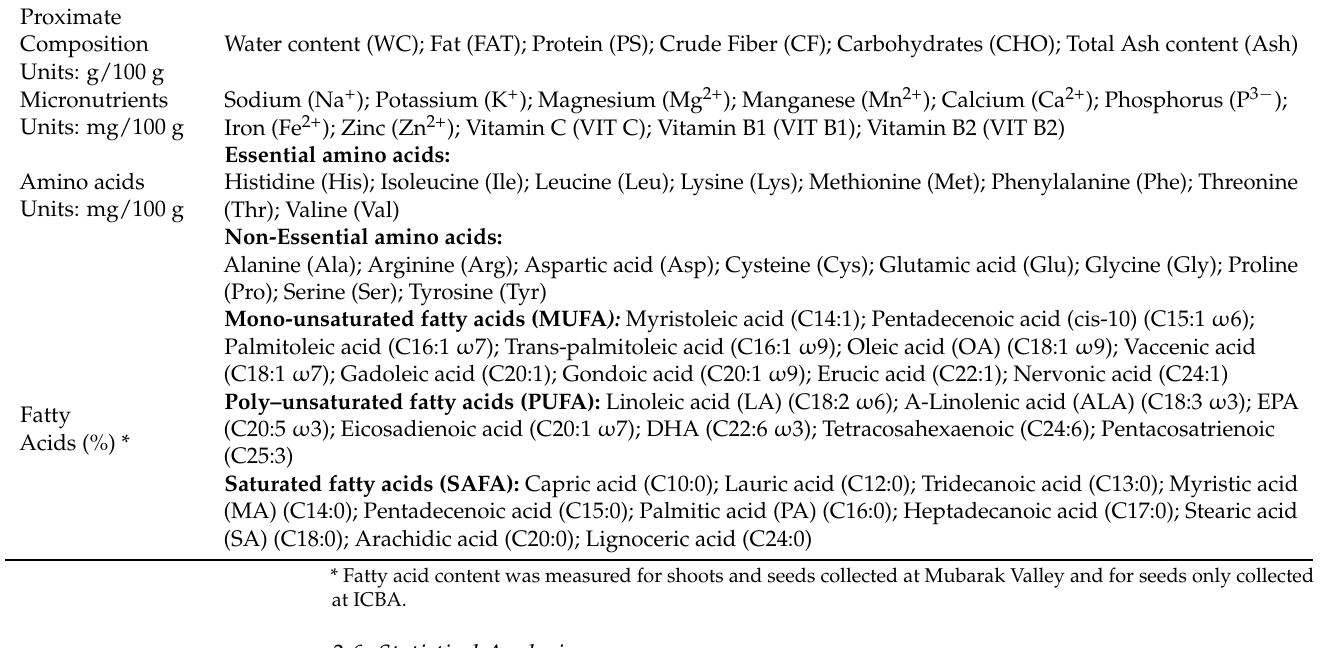
Table 3. Abbreviations and units of the nutritional parameters analyzed for Salicornia bigelovii shoots and seeds collected at ICBA and Mubarak